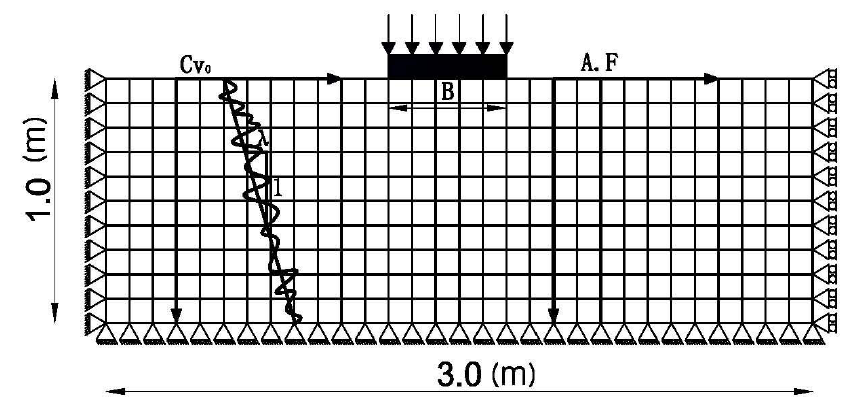
Fig. 4. Finite difference model used in Random Finite Difference Method (RFDM)